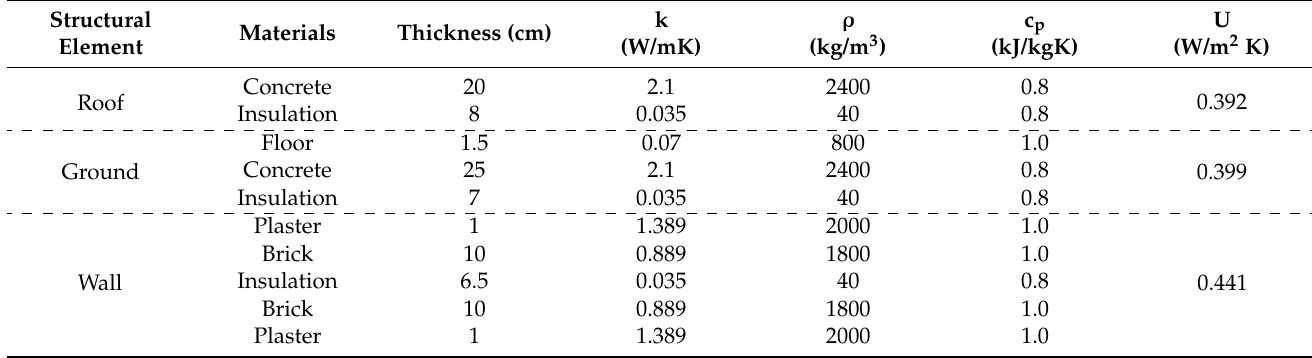
Table 1. Structural elements for the building in Athens (Zone B).